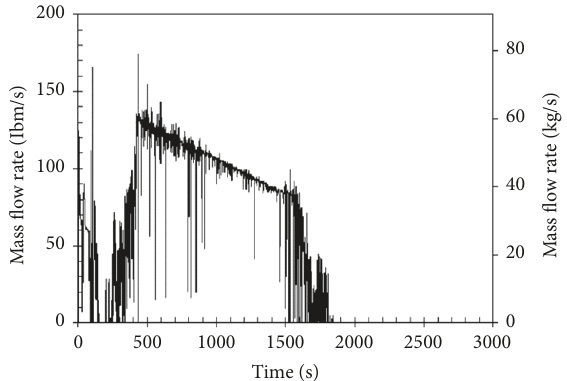
Figure 19: 10-inch Cold Leg Break: CMT-2 (NOTRUMP code) [7].